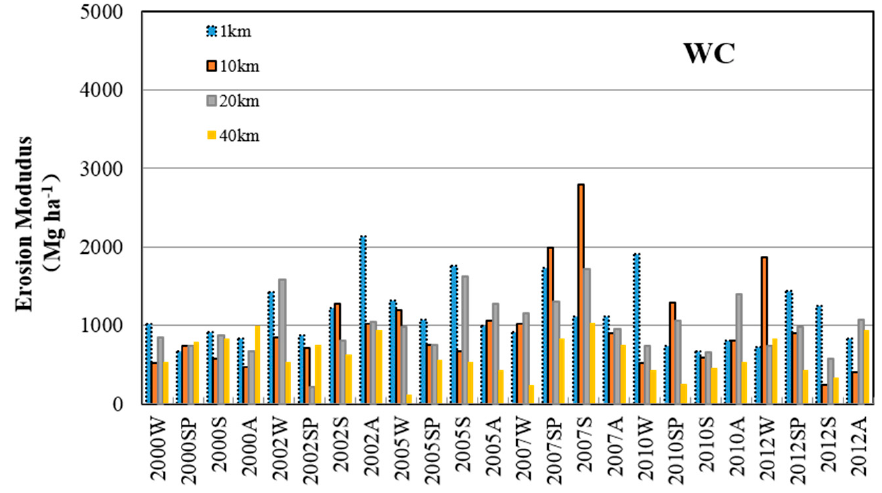
Figure 2. Cont Figure 2. Cont.